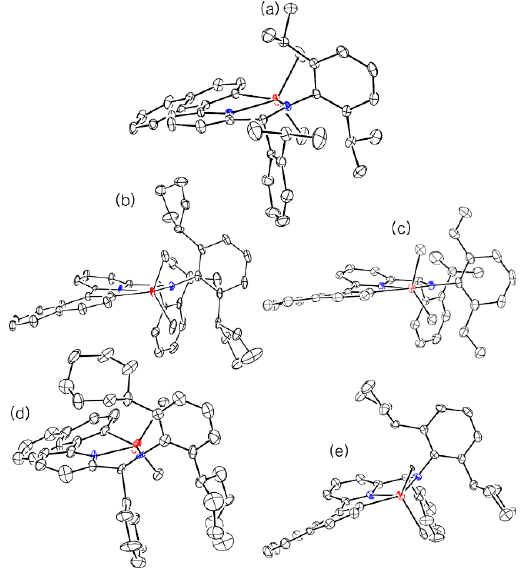
Figure 2. Thermal ellipsoid plots (a 30% probability level) of I ( a ), 21 ( b ), 23 ( c ), 34 ( d ), and 36 ( e ). Hydrogen atoms are omitted for clarity.